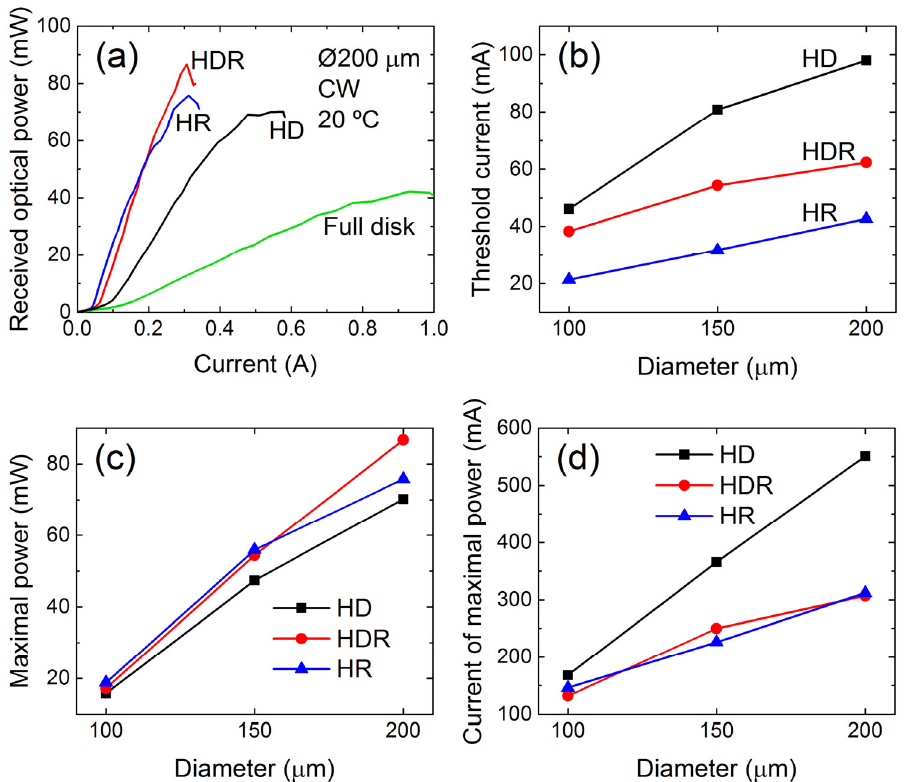
Figure 2. The light–current curves ( a ), threshold currents ( b ), maximal optical powers ( c ) and cur ‐ rents at which maximal powers are achieved ( d ) of HDs, HDRs and HRs of various diameters. Panel ( a ) also presents data for a Ø200 μ m full disk with round contact for comparison. Data correspond to 20 °C CW measurements of p ‐ side ‐ up mounted devices.